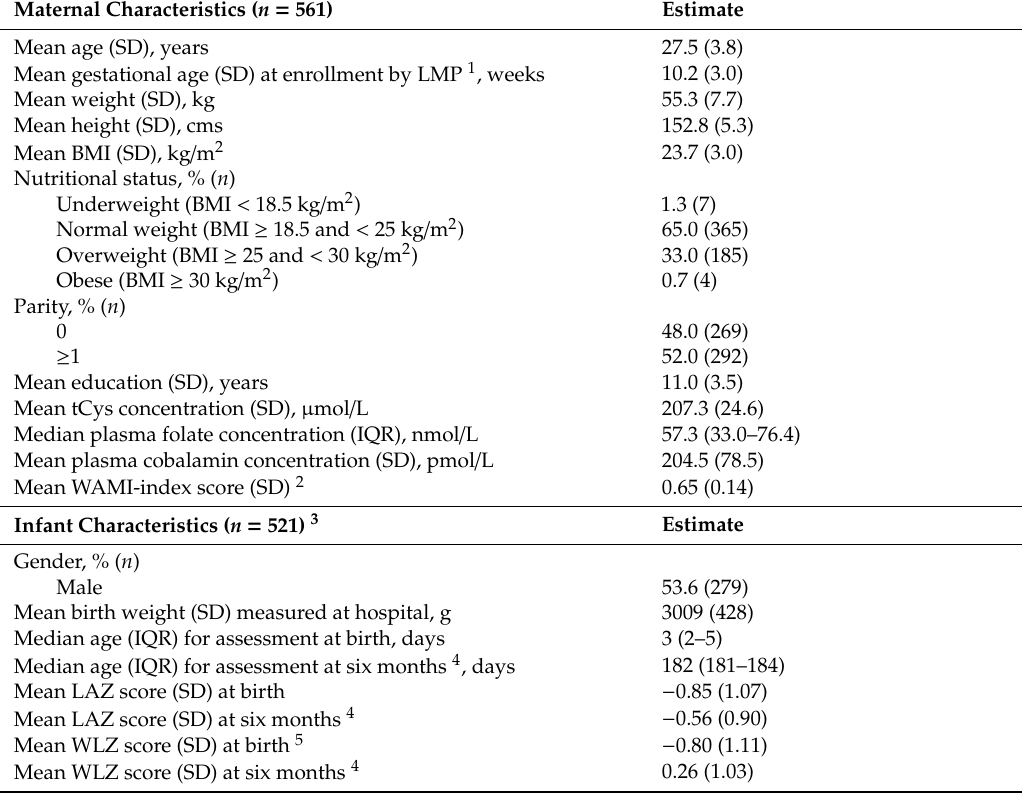
Table 1. Characteristics of study population.